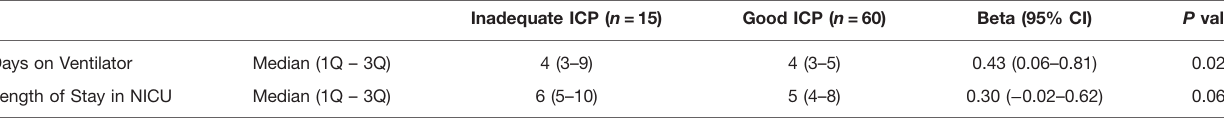
TABLE 3 | Adjusted ventilator days and length of stay in NICU using ICP threshold of 11